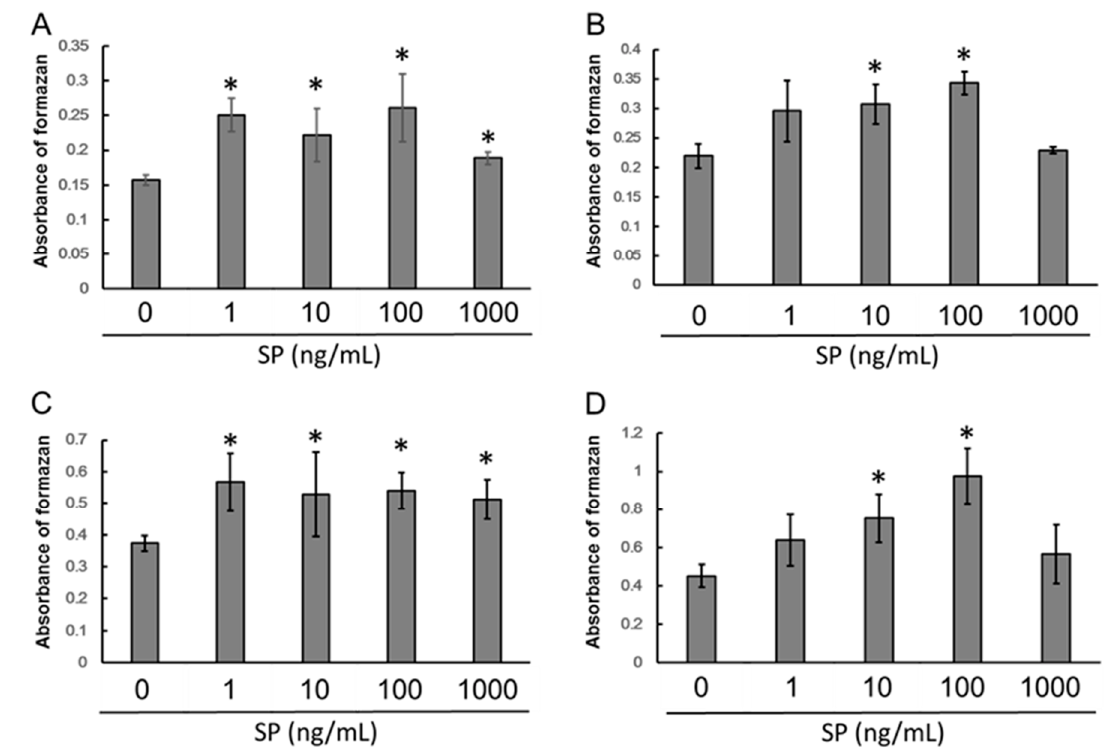
Figure 1. Effect of synthetic peptide (SP) on KN-3 cell proliferation. KN-3 cells were treated with 0 to 1000 ng/mL SP diluted in 100 µL culture medium. Cell proliferation was measured at 3, 8, 24, and 48 h. Significant differences (*, p > 0.05) were determined in comparison with the control (0 ng/mL SP). ( A ) 3 h, ( B ) 8 h, ( C ) 24 h, ( D ) 48.